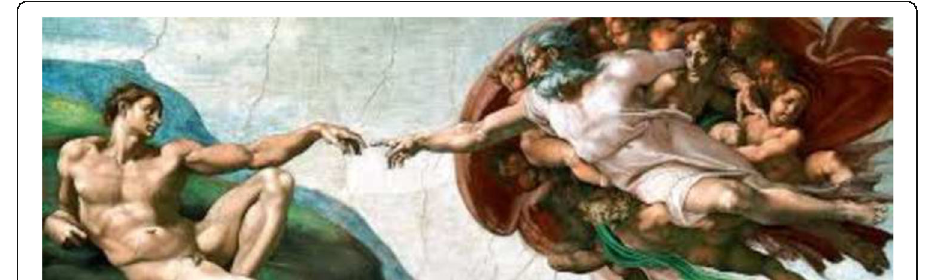
Fig. 7 The creation of Adam. The ultimate goal of education so often forgotten in the modern times: transmission of the invisible sparkle that inspires the soul of the student. A wonderful insight it is to realize that antiauthoritarian, inherently anarchic co-education, whereby the teacher and the student rapidly swap roles in pirouettes, inspiring one another in turns, is a means for the seamless accomplishment of this aim. The image is not subject to copyright